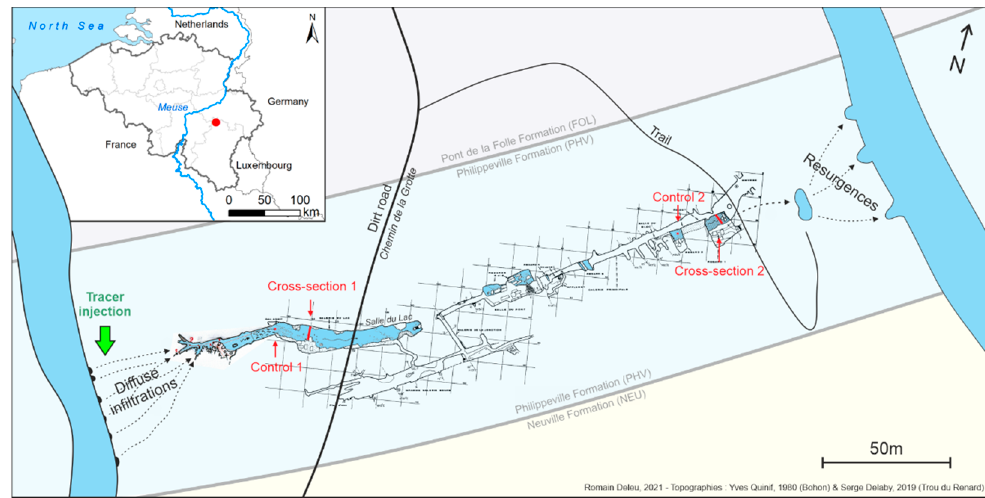
Figure 1. The Bohon Cave system is an underground “shortcut” for a portion of the Ourthe river through the meander. It extends along the Frasnian limestones of the Philippeville Formation. Topography of the cave is adjusted from Quinif, 1980 and Delaby, 2019 [9,10].